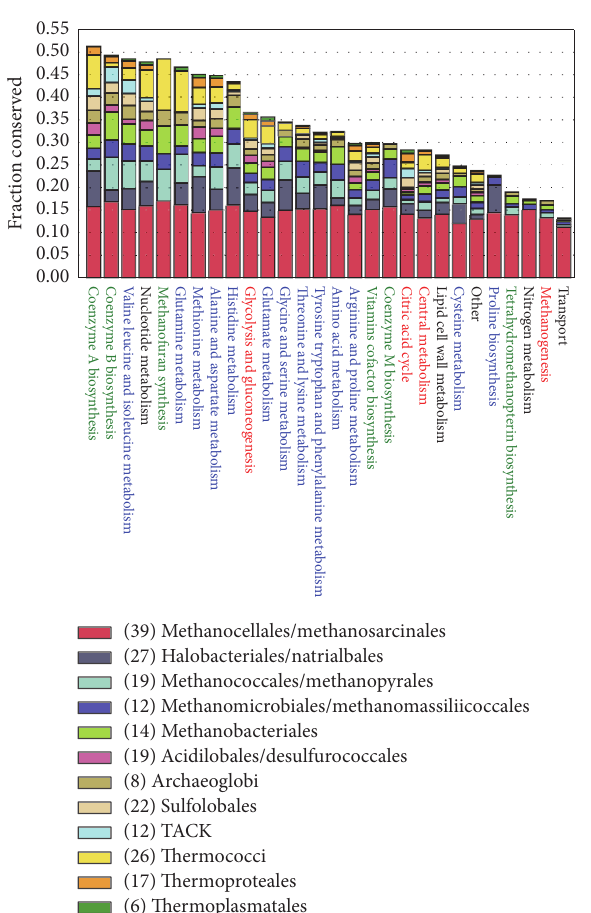
Figure 6: Fraction of conserved reactions. Grouping of the information shown in Figure 5 by metabolic subsystem (as annotated in i ST807). The overall height of each bar indicates the total fraction of reactions in the metabolic subsystem that are conserved, while the height of individual portions of each bar indicates the relative conservation of reaction in the subsystem from that organism. The 221 archaea were grouped by taxonomic order, yielding 12 distinct groups as seen in the legend. Metabolic subsystems labels are color coded: amino acid metabolism subsystems in blue, vitamin and cofactor metabolism subsystems in green, central metabolism subsystems in red, and other categories in black.